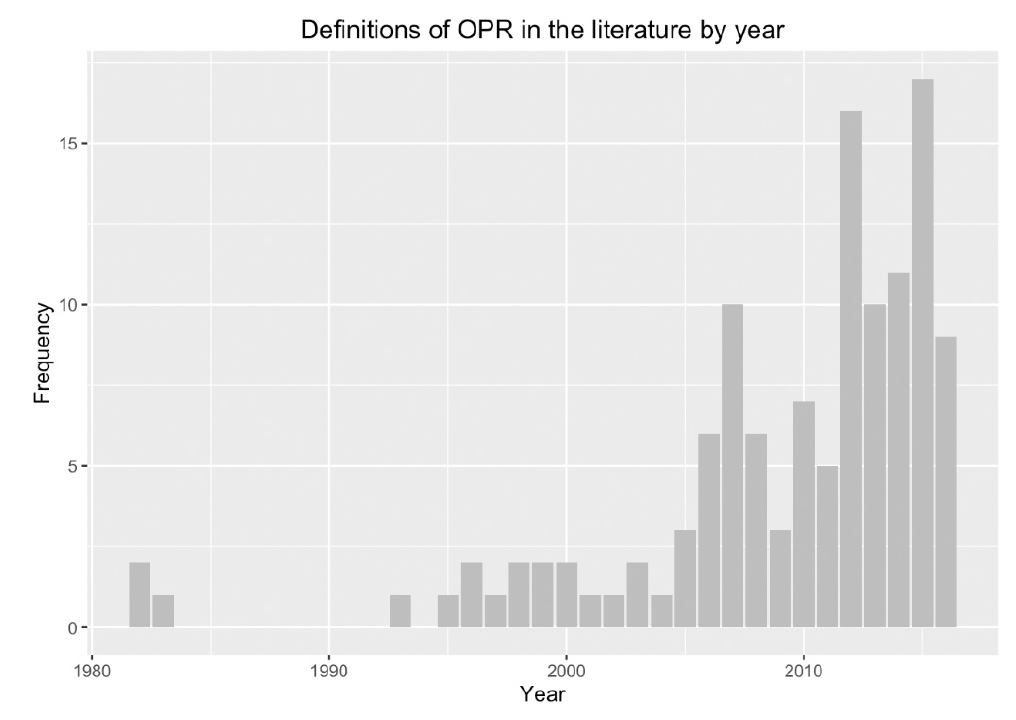
Figure 1. Definitions of OPR in the literature by